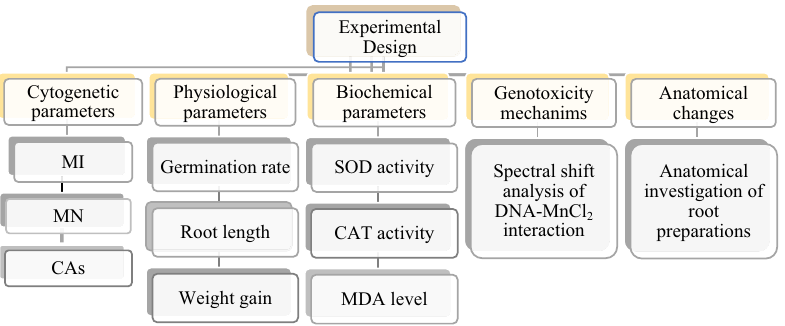
Figure 1. Experimental stages of study. MI mitotic index, MN micronucleus, CAs chromosomal abnormalities, SOD superoxide dismutase, CAT catalase, MDA